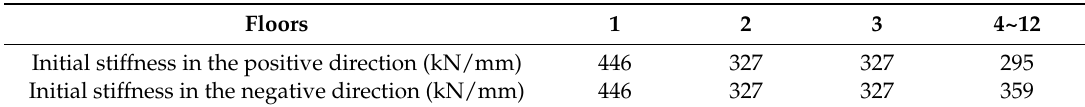
Table 4. Calculated parameters for test model.